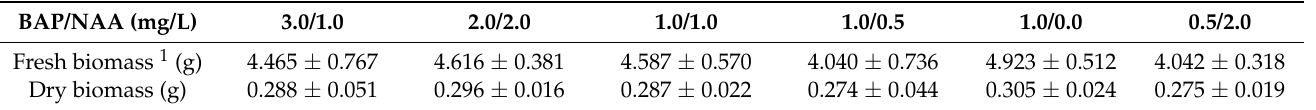
Table 1. Fresh and dry biomass increments of in vitro cultures of Scutellaria brevibracteata subsp. subvelutina during a 4-week growth cycle (MS medium variants with BAP and NAA).